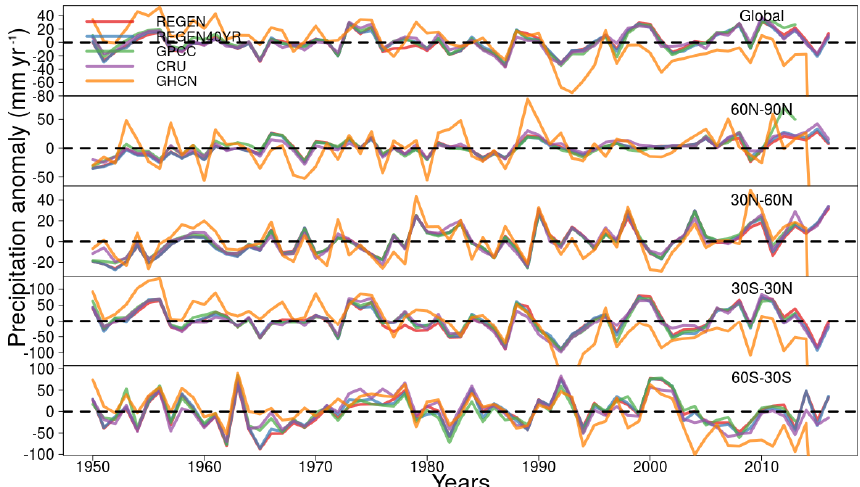
Figure 6. Comparison of annual precipitation anomaly time series with monthly datasets. Anomalies were calculated relative to the average of daily precipitation totals over the entire time period (1950–2016) for each